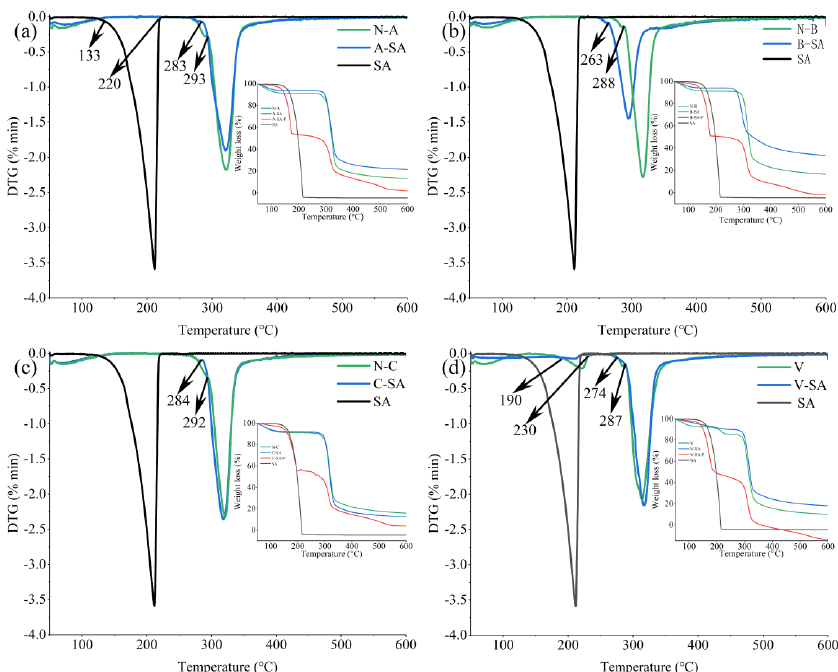
Figure 4. DTG curves of the four crystal types of starches, four inclusions, and SA. The insets are the TGA curves of ( a ) the thermogravimetric analysis curves of A–SA, A–SA–P, N–A, and SA; ( b ) the thermogravi- metric analysis curves of B–SA, B–SA–P, N–B, and SA; ( c ) the thermogravimetric analysis curves of C–SA,